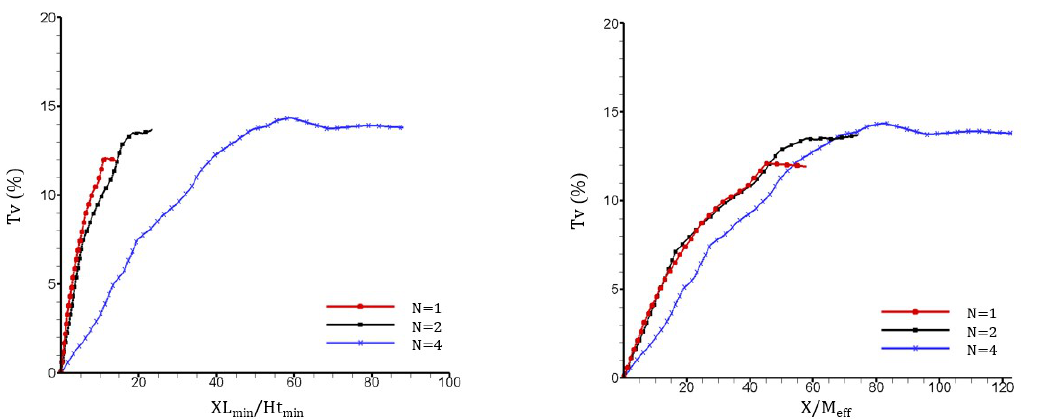
Figure 11. Centerline vertical turbulence intensity T v , normalized by the smallest scale ( left ) and the effective mesh size M ef f ( right ), downstream of each grid at Re =